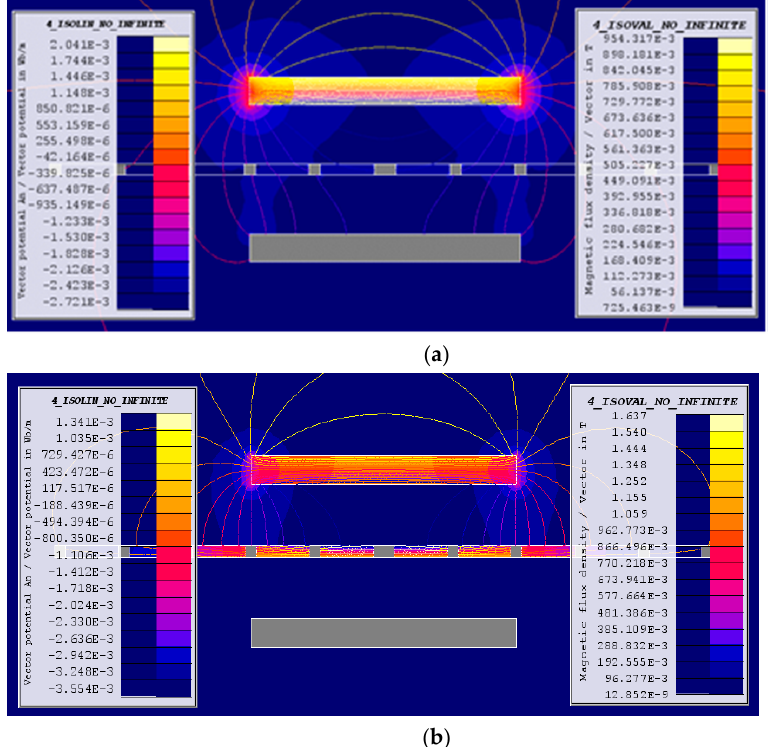
Figure 18. Density of magnetic field lines at DISTANCE_MP = 14 mm, THICKNESS_ROTOR = 2 mm, gadolinium (Gd) in the paramagnetic ( a ) and ferromagnetic ( b ) range. As stated on several occasions, the size of the magnetic force of attraction is of inter- est. The greater the magnetic force of attraction between the two constructive elements (stator and rotor) the better the gadolinium motor will behave under load conditions. 4.1. Variation of the Force of Attraction When the Distance between the Permanent Magnets Increases and the Permeability of Gadolinium Changes In Figure 19 can be observed the variation of the force of attraction when the distance between the permanent magnets increases and the permeability of gadolinium changes in the range considered. The increase in the force of attraction is noted with increasing per- meability and its decrease as the magnetic field is diminished (increasing the distance be- tween permanent magnets).